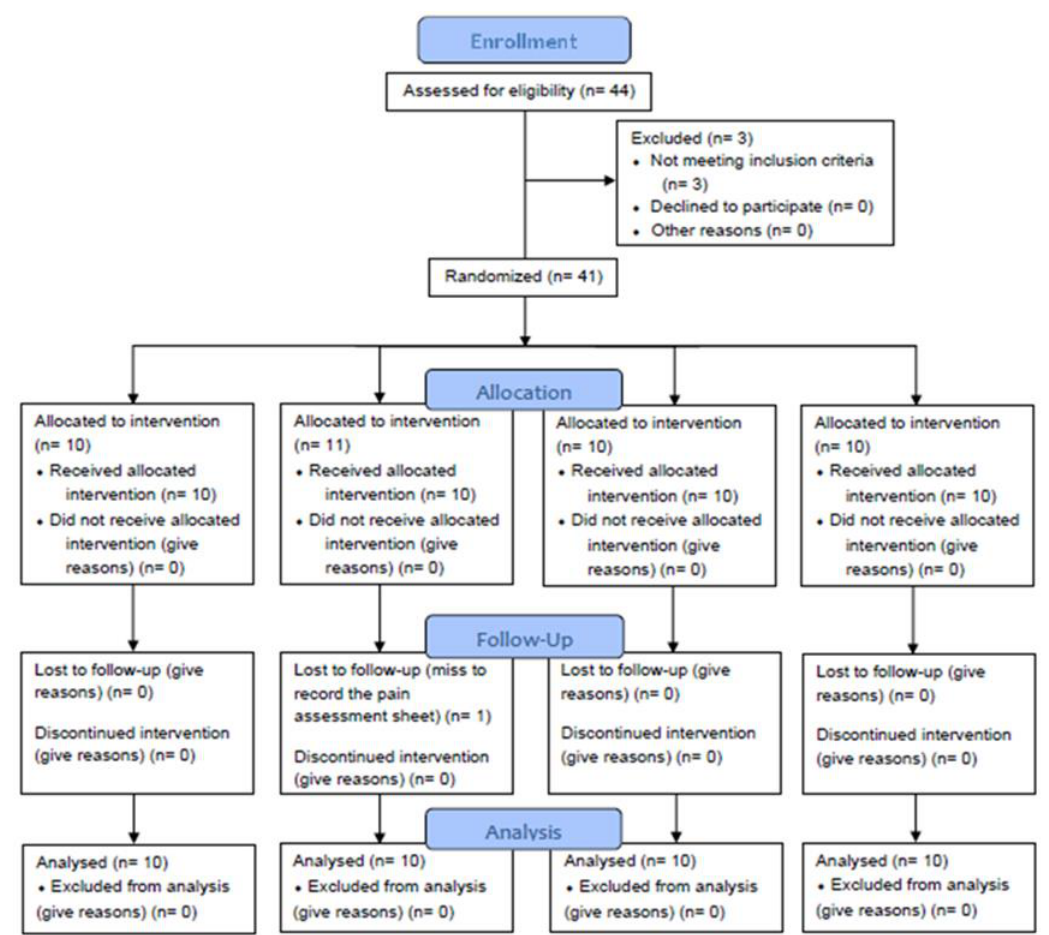
Figure 1. CONSORT flowchart of participants through each stage of the study. Pain levels between the drug